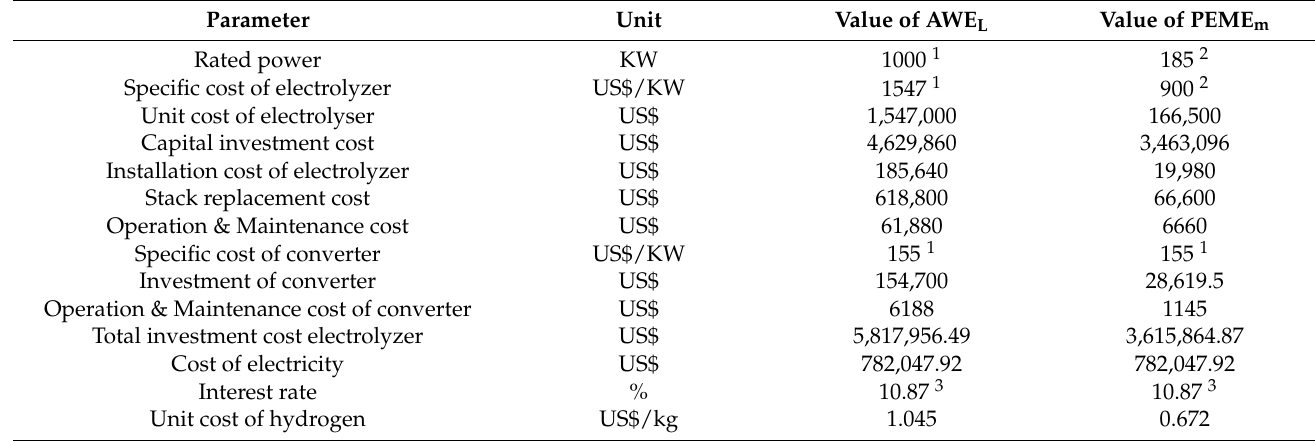
Table 3. Unit cost of hydrogen produced from wind energy.